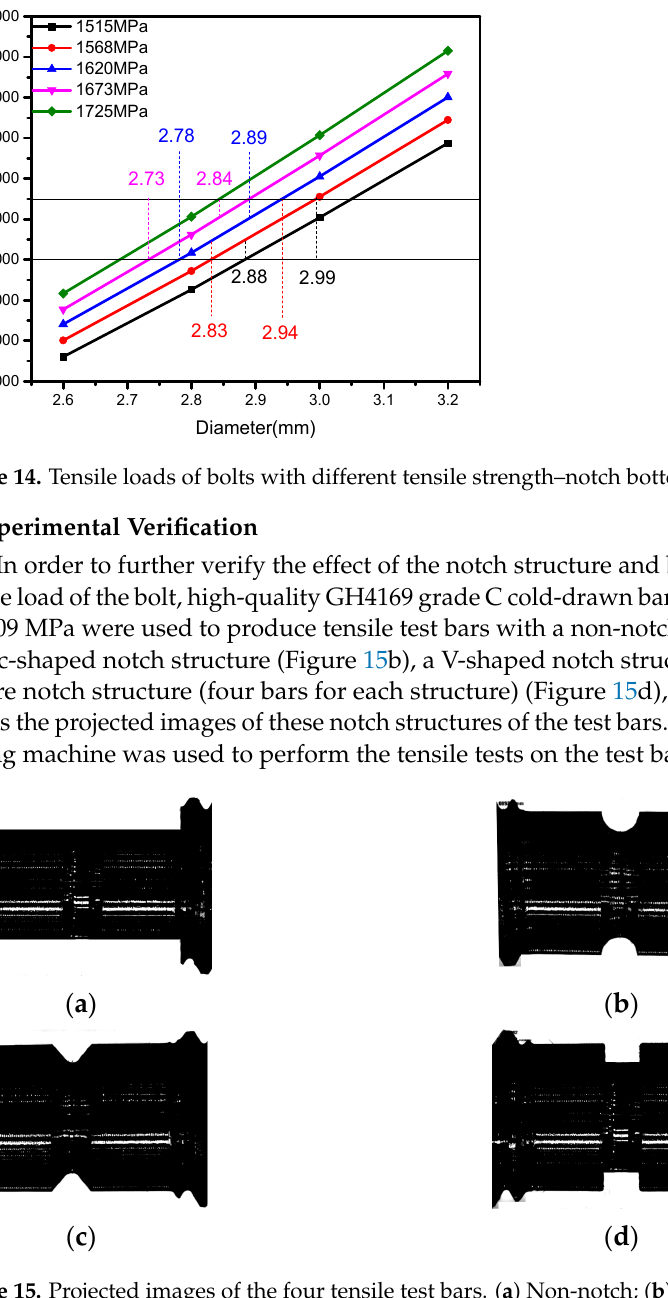
Figure 14. Tensile loads of bolts with different tensile strength–notch bottom diameter pairs.